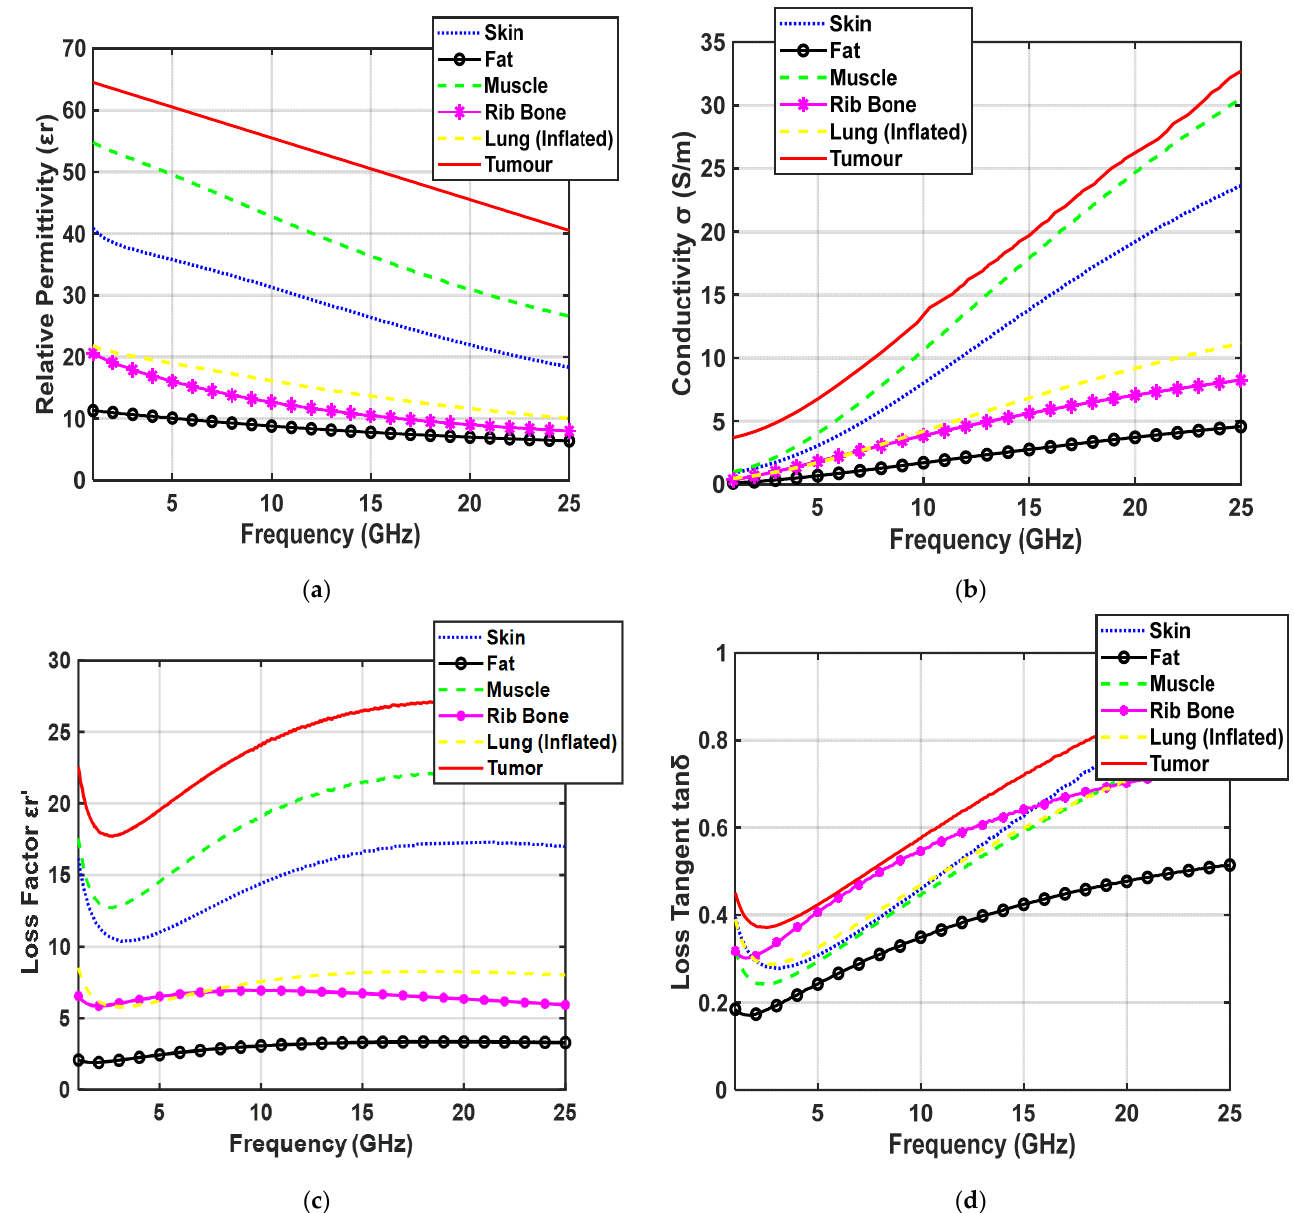
Figure 2. Dielectric properties of human torso and tumor issues: ( a ) Relative permittivity; ( b ) Conductivity; ( c ) Loss factor; ( d ) Loss tangent.